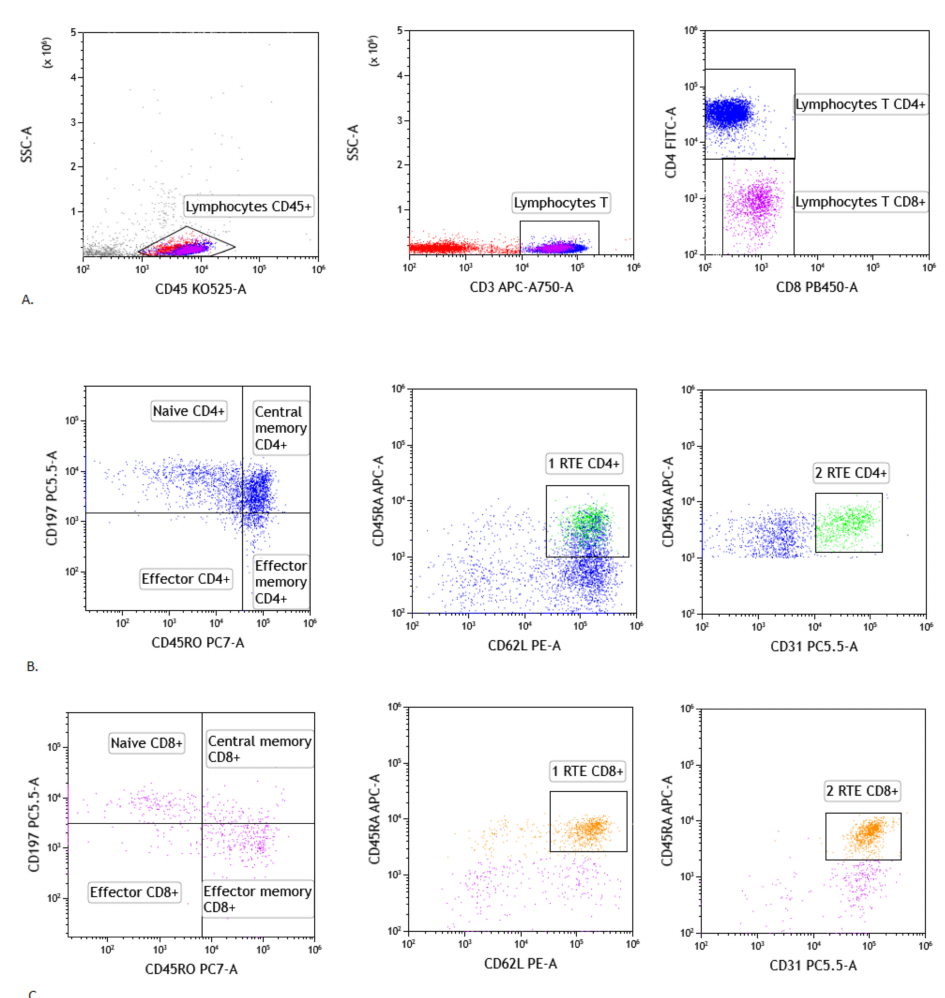
Figure 1. Gating strategy of T lymphocytes maturation in lymph node. ( A ) Selection of lymphocytes based on their SSC/CD45+ position, CD3 vs. SSC-A plot: Selection of lymphocytes T based on their SSC/CD3+ position. CD4 vs. CD8 plot: Selection of lymphocytes T CD4+ (blue) and CD8+ (purple) based on their CD4+ or CD8+ position. ( B ) Representative dot plots of T CD4+ subsets cells: naïve CD4+ T cells, effector CD4+ T cells, central memory CD4+ T cells, effector memory CD4+ T cells and recent thymic emigrants T CD4+ cells (gating strategy of RTE T CD4+ cells consist of two plots: 1RTE+ 2RTE - green), based on antibodies described in section: Material and Method. ( C ) Representative dot plots of T CD8+ subsets cells: naïve CD8+ T cells, effector CD8+ T cells, central memory CD8+ T cells, effector memory CD8+ T cells and recent thymic emigrants T CD8+ cells (gating strategy of RTE T CD8+ cells consist of two plots: 1RTE+ 2RTE - orange), based on antibodies described in Material and